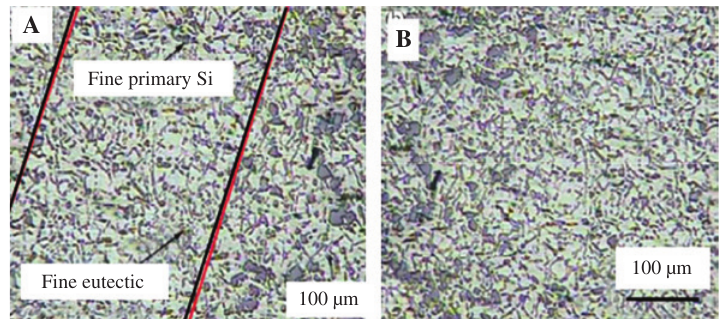
Figure 18: (A) SEM microstructure of the prepared sample at 860 ° C. (B) SEM micrograph of the sample prepared at 35-s decanting time